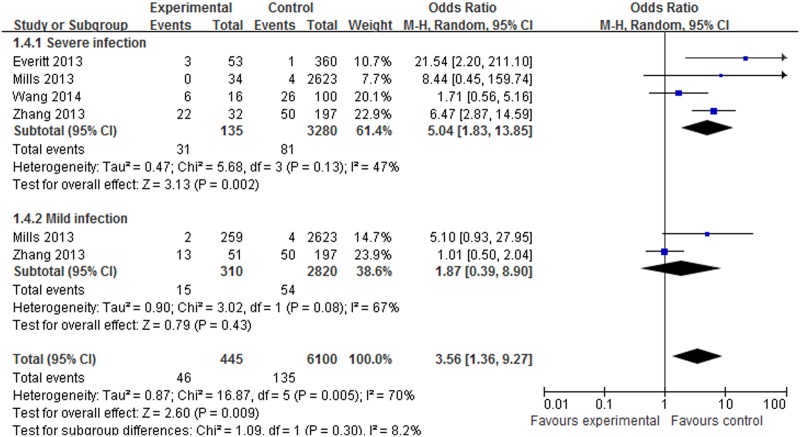
The forest plot for the association between SNP rs12252 of IFITM3 and influenza susceptibility in the recessive model (CC vs. CT+TT), subgroup analysis by different severity.The individual block squares denote the susceptibility for each study published during 2014, with an area proportional to the amount of statistical information in each study. The horizontal line denotes a 95% confidence interval (CI). The pooled estimate and its 95% CI are represented by a diamond.